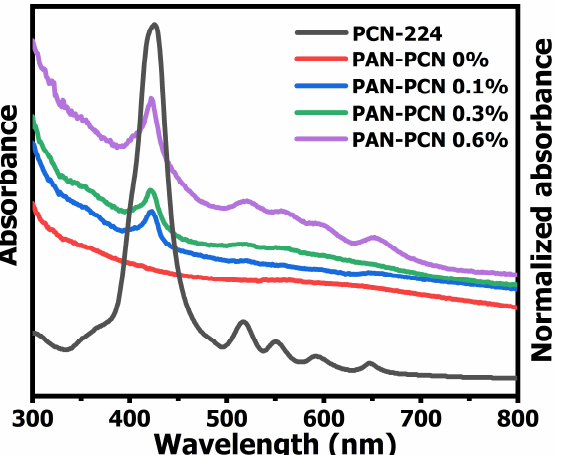
Figure 2. ( a ) SEM image and ( b ) energy-dispersive spectroscopy (EDS) results of PAN-PCN 0.6% nanofibers. ( c–f ) EDS mappings identifying the elemental distributions of C, N, O and Zr.